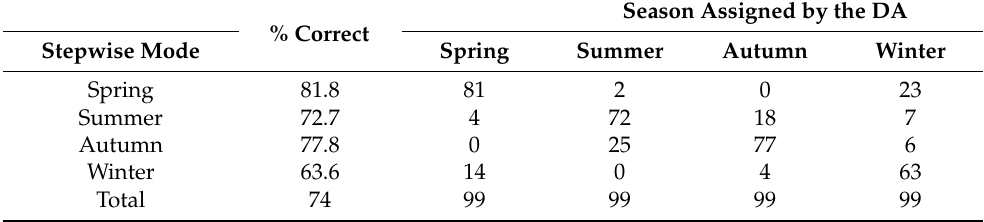
Table 5. Classification matrix for discriminant analysis (DA) of temporal variations in Andong Reservoir water quality (spring: March–May; summer: June–August; autumn: September–November; and winter: